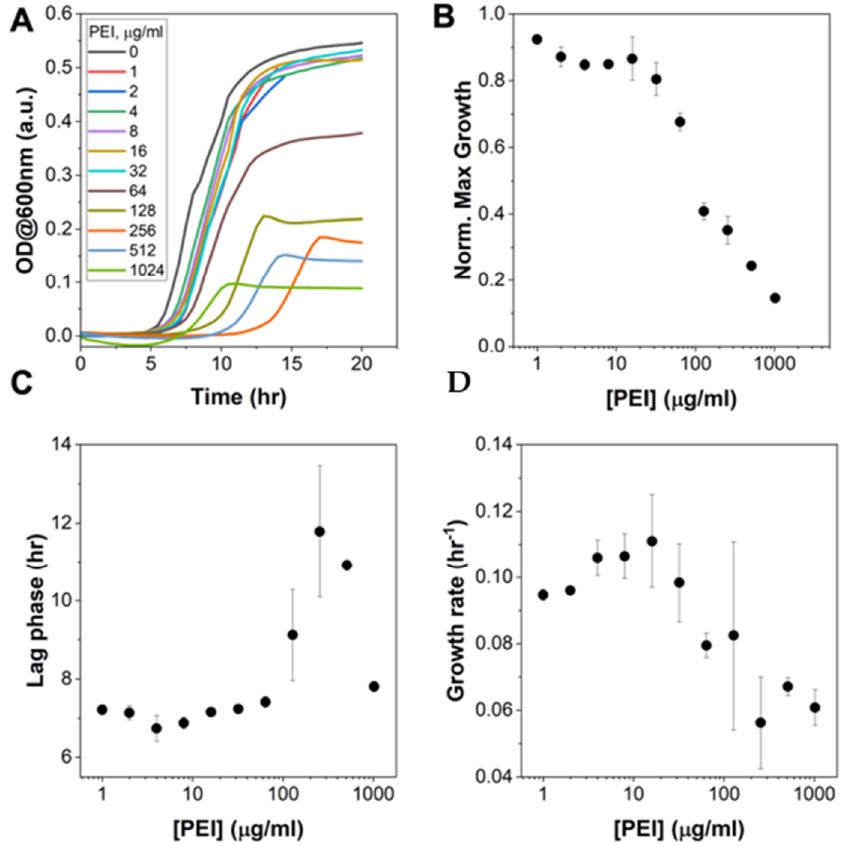
Figure 3. ( A ) Growth curves of E. coli in M9 minimal media after they were pre-treated with increasing concentrations of PEI (60 kDa) for 15 min. Using the Gompertz equation (see Figure S9) to fit the growth curves in ( A ), the maximal growth ( B ), lag time ( C ), and growth rate ( D ) were obtained as a function of PEI concentration.